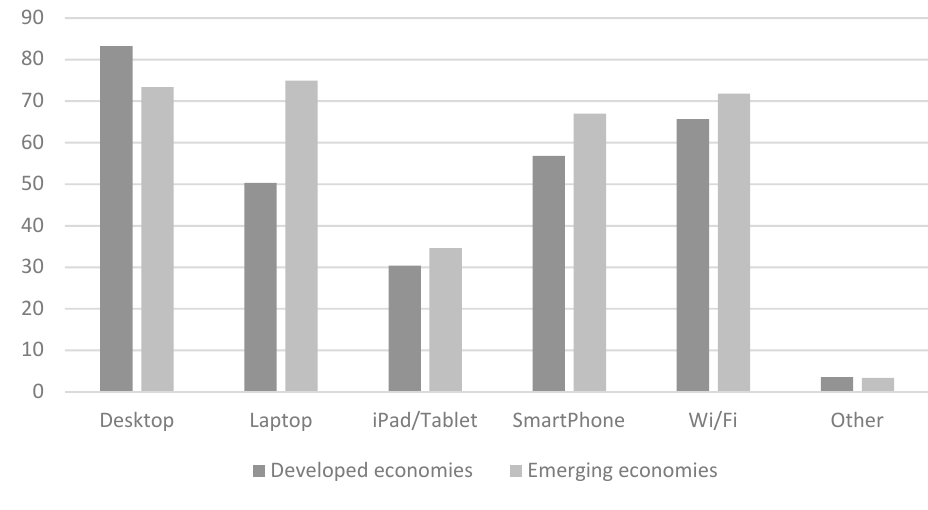
Figure 4. Access to technology.